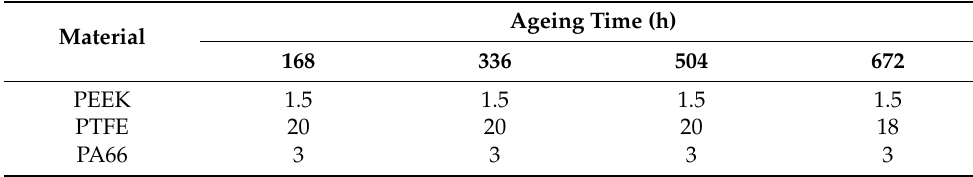
Table 4. Traction speed (in mm/s) by material and ageing time.